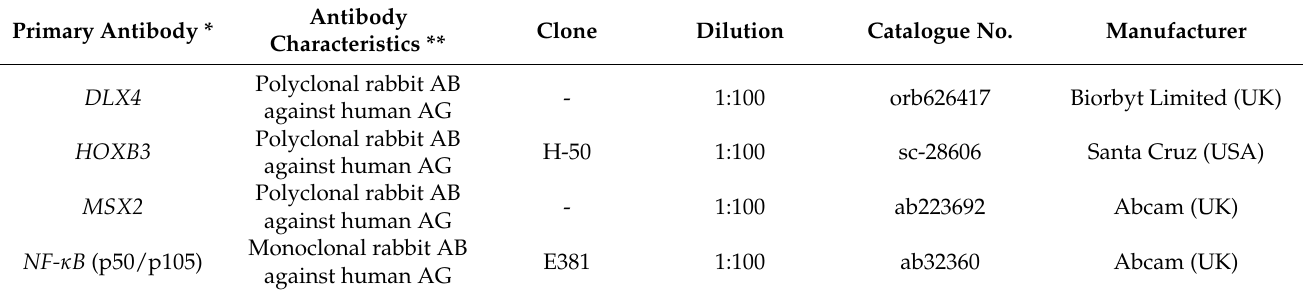
Table 3. Description and characteristics of the primary